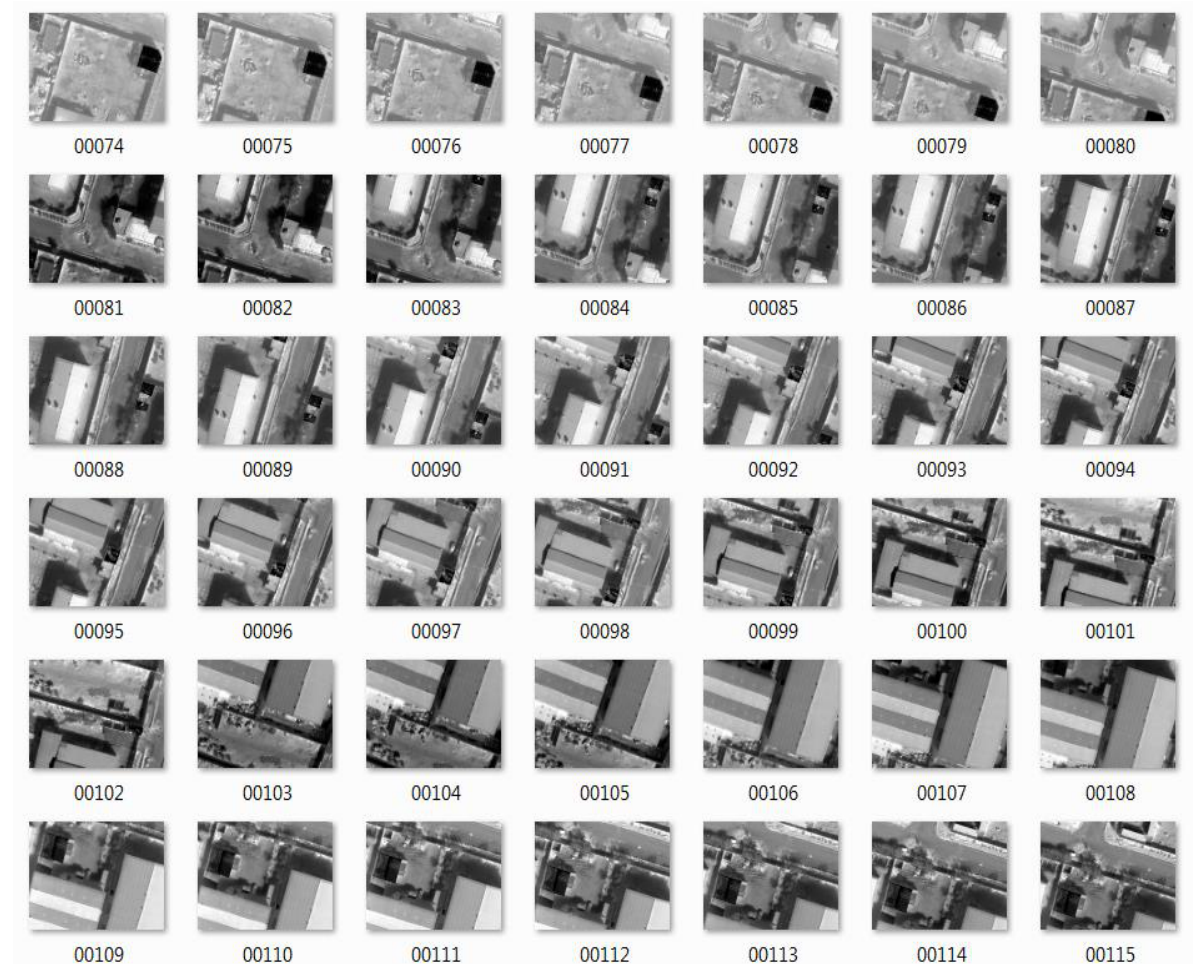
Figure 2. Some of the frames taken from UAV